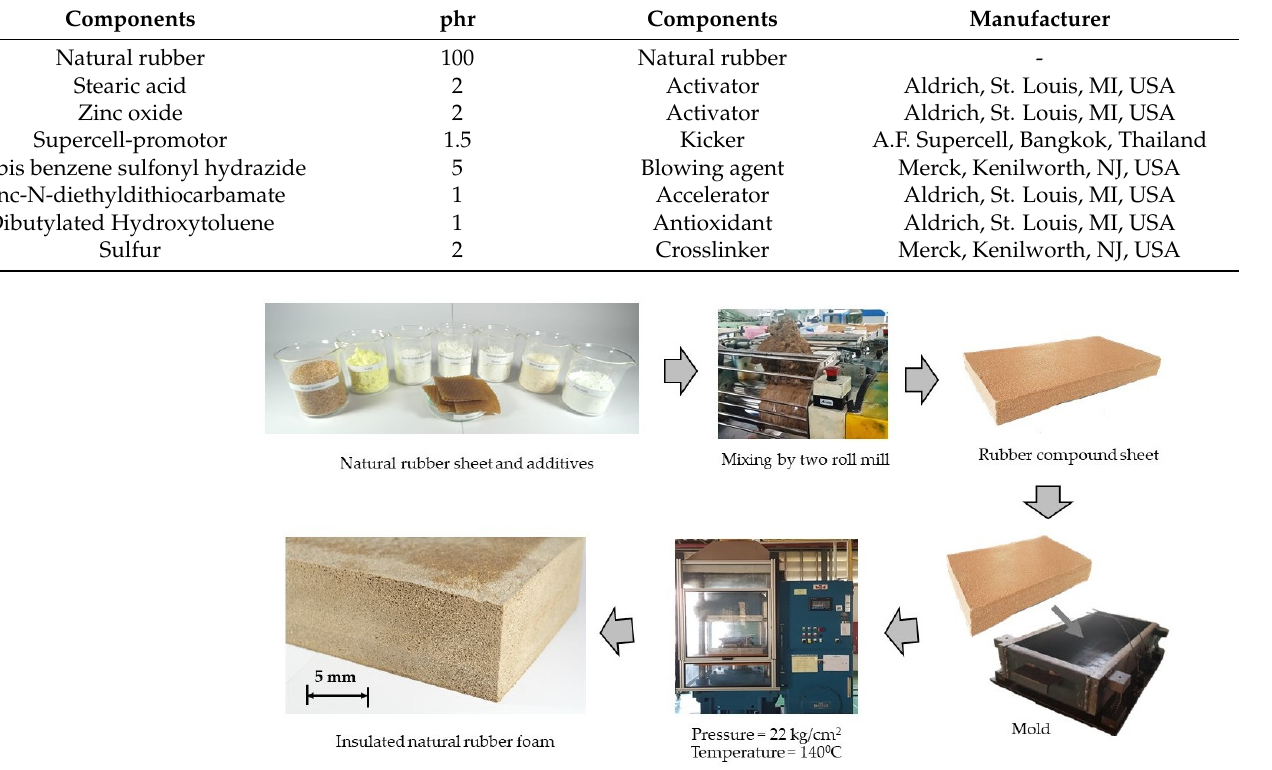
Figure 1. Flowchart of the manufacture of natural rubber foam in laboratory.